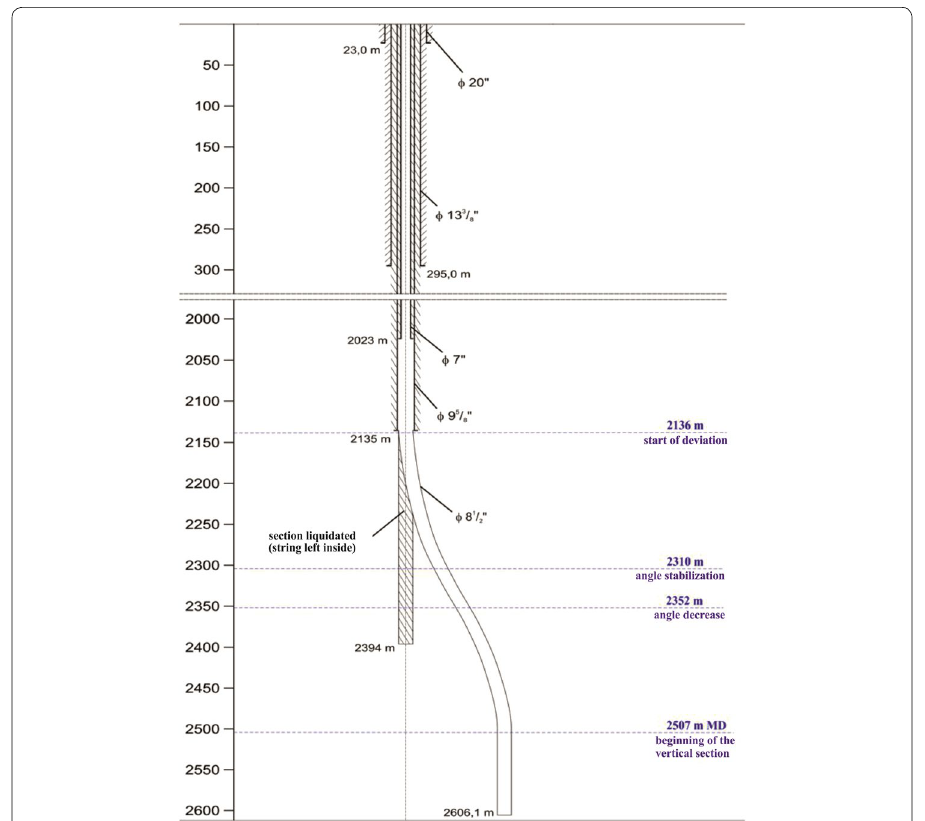
Fig. 14 Schematic structure of the Biały Dunajec PAN-1 well post-reconstruction (based on Bujakowski et al.